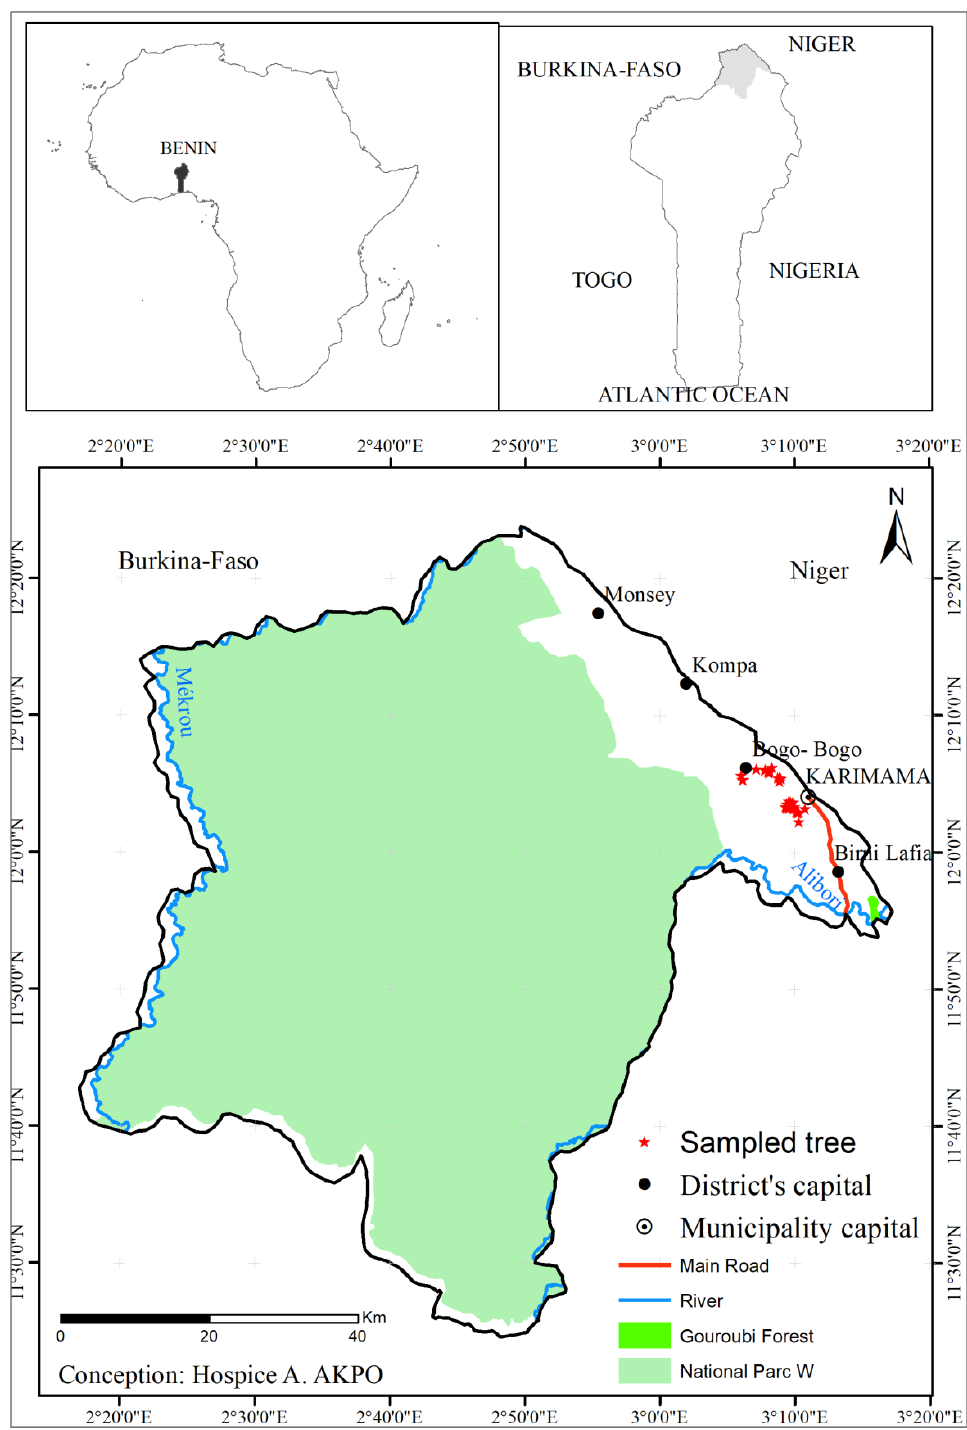
Figure 1. Map of study area.